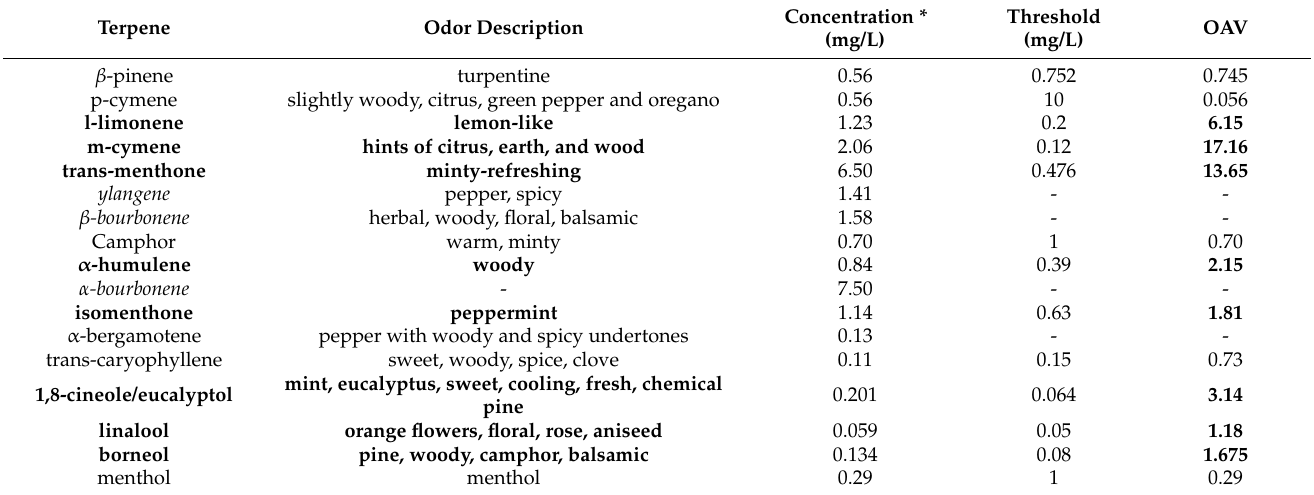
Table 2. Relative concentrations, odor description, threshold, and OAV of key terpenes and terpen alcohols detected in the